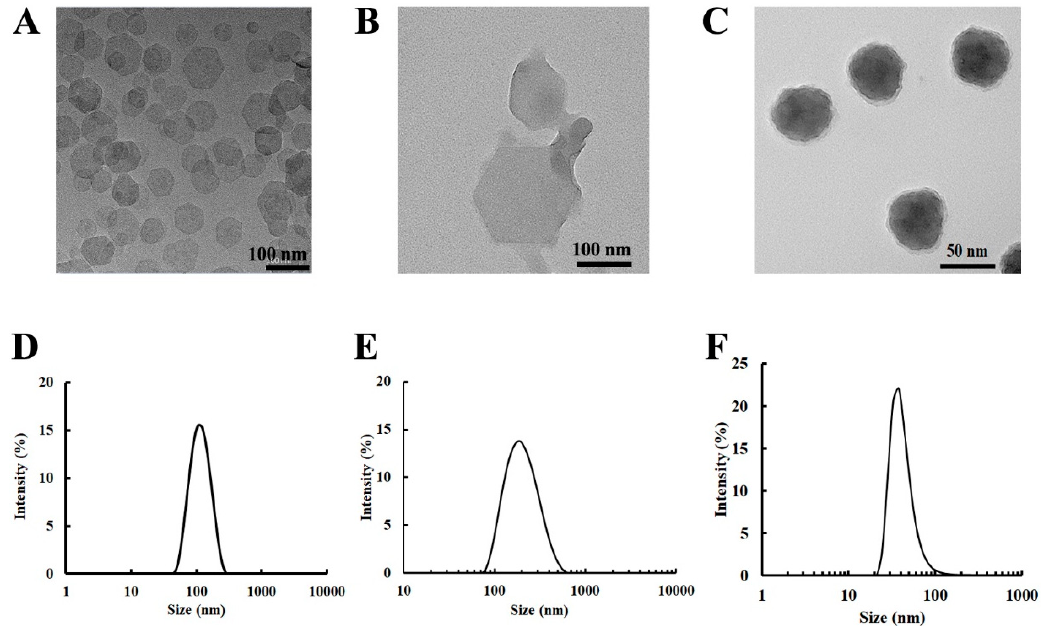
Figure 1. Particle morphology and particle size distribution. The upper penal shows the morphology of the nanoparticles used in this study ( A ) Mg 2 Al-Cl-LDH; ( B ) bovine serum albumin (BSA) on layered double hydroxide nanoparticles (BSA-LDH) in PBS; and, ( C ) lipid-coated calcium phosphate (LCP). The lower panel shows the size distributions of the corresponding nanoparticles (NPs) in the upper panel (i.e., ( A , D ); ( B , E ); and, ( C , F